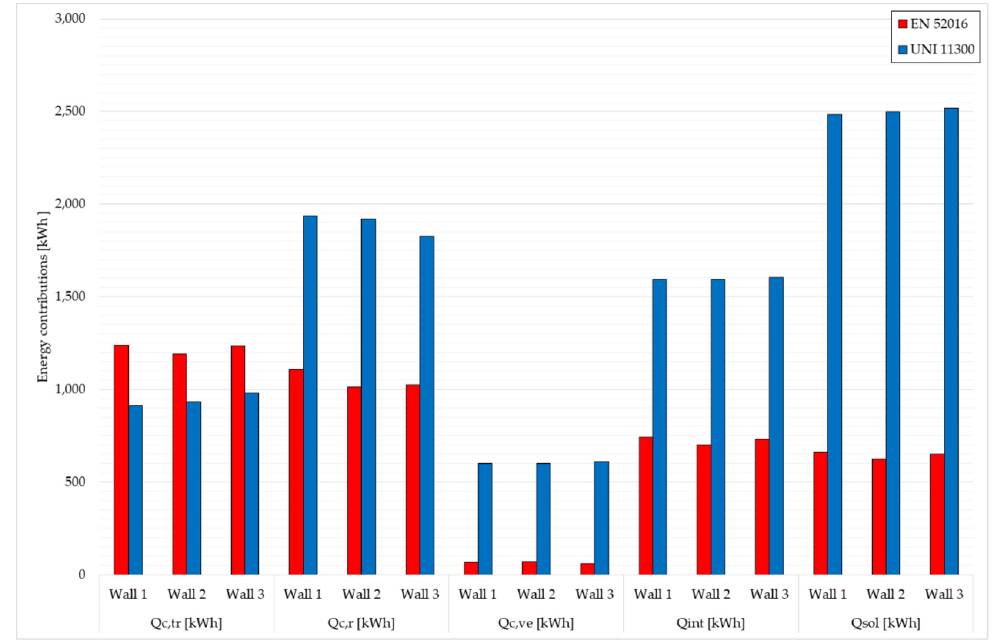
Figure 9. Energy-contribution comparison during the cooling period: UNI 11300 vs. EN 52016 (Q c,tr = heat losses for transmission through the building envelope; Q c,r = extra heat flow due to thermal radiation to the sky; Q c,ve = heat losses for ventilation; Q int = internal heat gains; Q sol = solar radiation through windows). The primary energy needs (EP) for heating and cooling, in compliance with the en- ergy balance of UNI 11300 and EN 52016, were finally evaluated. The results are shown with and without photovoltaic systems (PV) in Figure 10 Error! Reference source not found. . In particular, results are shown for renewable (EP ren ), non-renewable (EP ren ), and total (EP tot ) primary energies [37] of the global primary energy (EP gl ) [20–23], i.e., for the present study, primary energy need was calculated as the sum of the primary energy needs for heating (EP H ), cooling (EP C ), and domestic hot-water production (EP W ). In Figure 10, the grey bars represent the global primary energy need (EP gl,tot -kWh), i.e., the sum of the primary energy needs for heating (red bars), cooling (blue bars), and domestic hot-water production, the orange-dashed bars are the renewable contributions to primary energy (EP gl,ren ), the green-dashed bars are the non-renewable contribution (EP gl,n-ren ), whilst the green dots with black lines are the electric energy demand required by the case studies (wall 1, wall 2, and wall 3) with and without a PV system. As per to Figure 10, the EP gl,tot calculated with EN 52016 was always lower than when returned by UNI 11300, by about 12% for walls 1 and 2, and by 13.3% for wall 3. The EP H , tot for heating, assessed with both calculation methods, was very close between them, with a small difference of about 6%. The main differences were found for cooling (EP C , tot ), in- stead, where UNI 11300 returns much higher values (greater than 90%). These results can be due to the simplified calculation method provided by UNI 11300, which fails to account for the real complexity of exchanges during the cooling period. The new innovative wall (wall 3) equipped with a thermally insulating panel made of recycled PET was determined to be the less energy-intensive wall, requiring a EP gl,tot between 8800 kWh (EN 52016) and 9400 kWh (UNI 11300), so confirming results from past studies, such as those of Ingrao et al. [10] and Maalouf et al. [34]. Similar trends can be highlighted when considering the electrical energy demand for all the case studies; for this analysis, the non-renewable, renewable, and total-conversion factors for electrical energy of 1.95, 0.47, and 2.42, respectively, were considered. addition- ally, in this case, UNI 11300 returned much higher results, of about 21–23%, mainly due